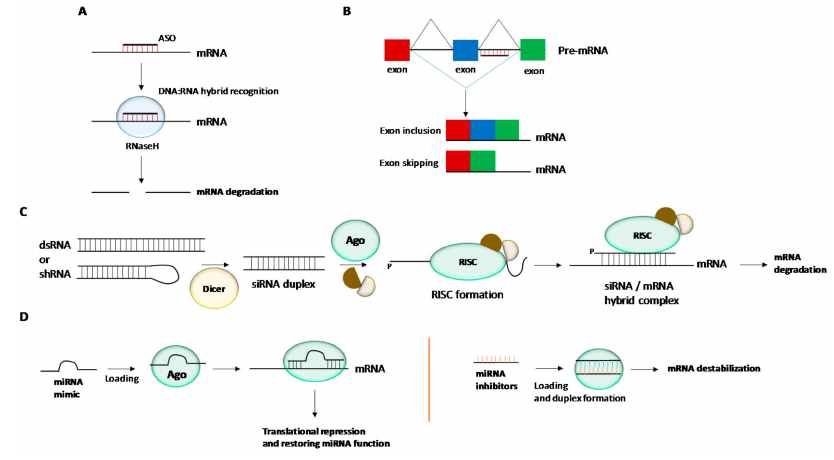
Figure 1. Gene regulation mechanisms mediated by antisense oligonucleotides (ASOs), triplex-forming oligonucleotides (TFOs), small interference RNAs (siRNAs) and microRNAs (miRNAs). ( A ) Antisense